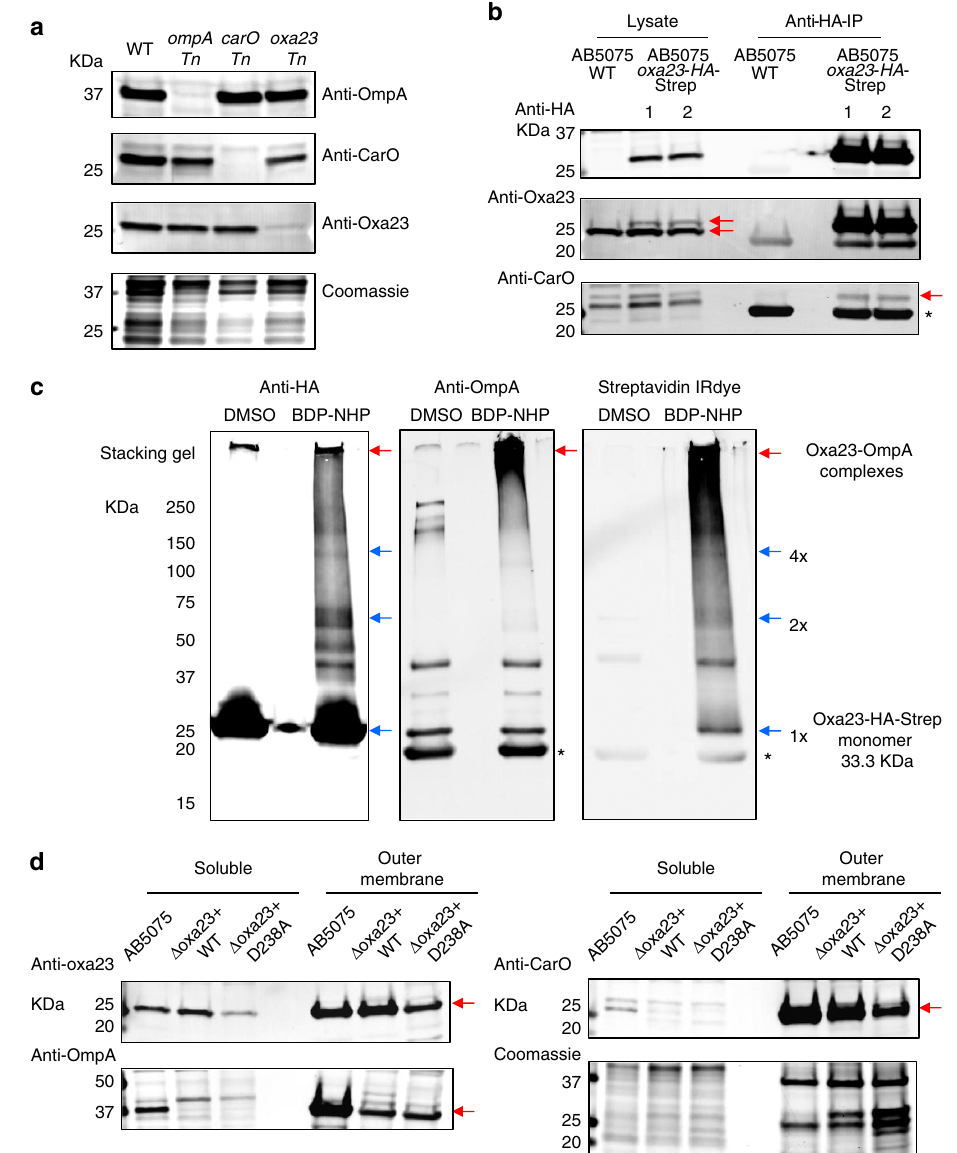
Figure 4 | Validation of Oxa-23 interactions with CarO and OmpA. ( a ) Antibody specificity was confirmed with detection of protein bands that matched the molecular weight of the target proteins (OmpA, CarO and Oxa-23). Furthermore, the detected protein bands also matched the sizes of protein bands that showed reduction in specific transposon mutants ( ompA Tn , carO Tn and oxa-23 Tn ). ( b ) Co-IP analysis of anti-HA antibodies with AB5075-pMMB- oxa23 cell protein lysates. Red arrows in anti-Oxa23 immunoblots indicate the detection of both the endogenous Oxa-23 and the tagged Oxa-23. Red arrow in anti-CarO immunoblots indicates CarO proteins that were co-immunoprecipitated with Oxa23-HA-Strep in AB5075. Asterisk corresponds to the immunoglobulin light chains. ( c ) Co-IP analysis of anti-HA antibodies with the BDP-NHP cross-linked AB5075-pMMB- oxa23 cells. Blue arrows indicate that protein bands matching the sizes of Oxa23-HA-Strep monomers (1 (cid:3) ), dimers (2 (cid:3) ) and tetramers (4 (cid:3) ) could be immunoprecipitated with anti-HA antibodies after the BDP-NHP cross-linking reactions. Red arrows show that higher molecular weight bands reactive to anti-OmpA antibodies could be pulled down with the anti-HA antibodies, supporting the identification of Oxa23-OmpA protein interactions. Streptavidin IRdye confirmed that the high molecular weight bands contained strong biotin (that is, cross-linking) signals in the cross-linked samples, but not in the dimethyl sulfoxide (DMSO)-treated control samples. Asterisks correspond to the immunoglobulin light chains. ( d ) OM protein-enriched fractions were prepared from AB5075 WT, or D oxa23 complementation mutants with pMMB.A1- oxa23 ( (cid:2) WTor (cid:2) D238A) cells. Two micrograms of protein were loaded for each lane. Strong anti-Oxa23 immunoblot signals were observed at the OM-enriched fractions. Enrichment of OM-protein markers OmpA and CarO are also shown in these samples. Red arrows indicate the detection of specific protein bands, Oxa-23, OmpA and CarO. Coomassie-stained gel shows the loading of equal total proteins. Full blots are shown in Supplementary Fig.